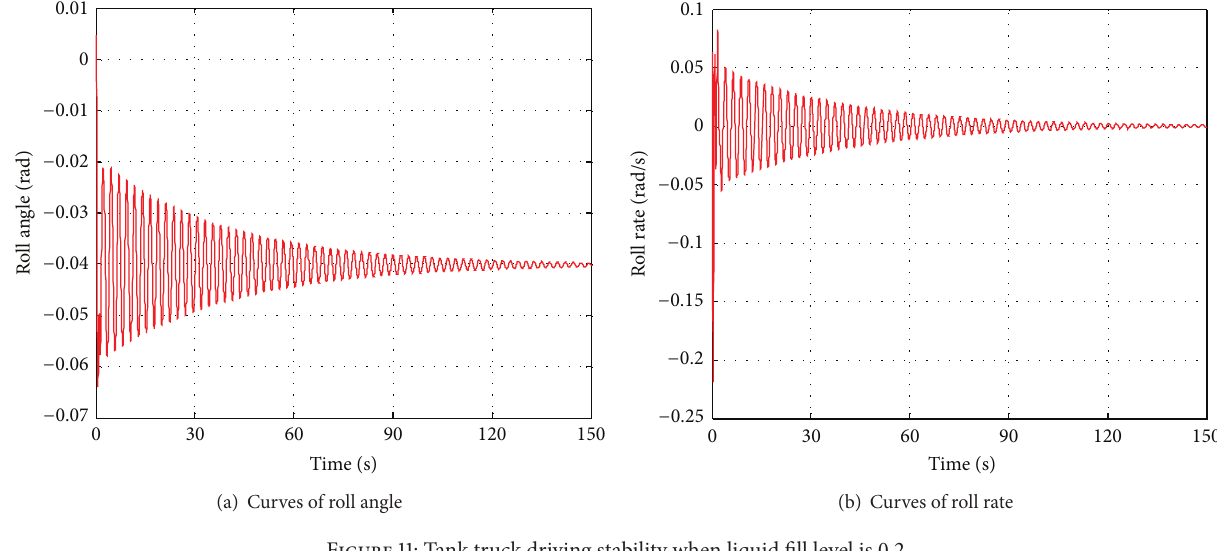
Figure 11: Tank truck driving stability when liquid fill level is 0.2.